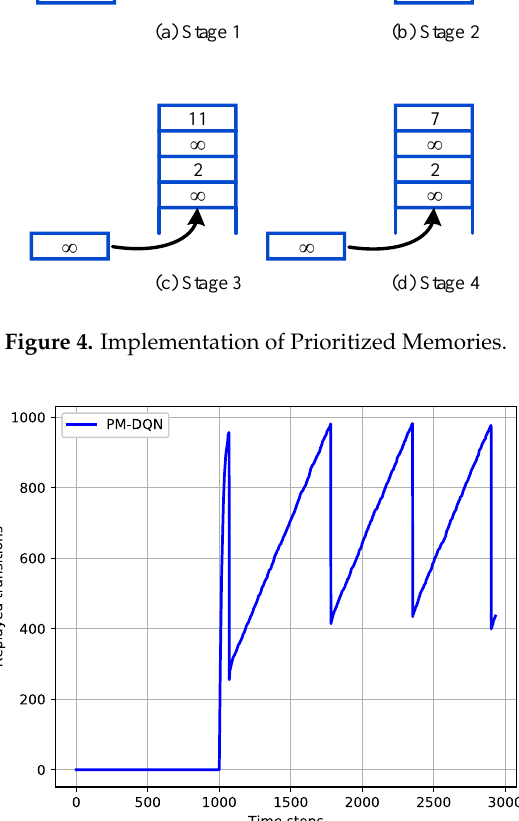
Figure 5. Variation trends of the transition quantities in PM-DQN. Algorithm 1: Prioritized Memories Deep Q-learning